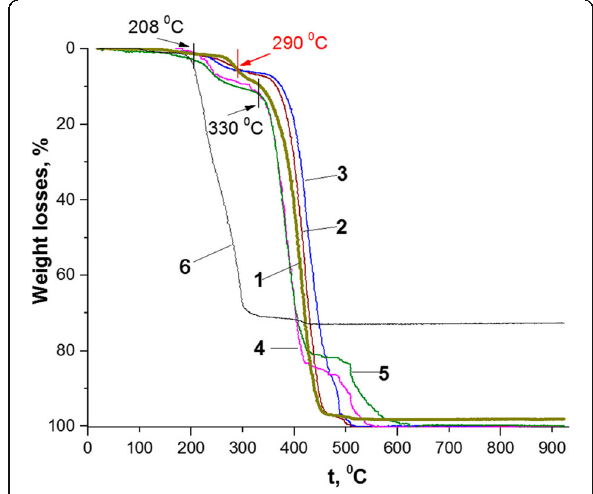
Fig. 4 Thermogravimetric curves of the PS/PANI-LSA nanocomposites with different PANI-LSA contents (wt%): 1 PS, 2 1.84 (NC2), 3 3.01 (NC3), 4 11.27 (NC11), 5 14.82 (NC15), 6